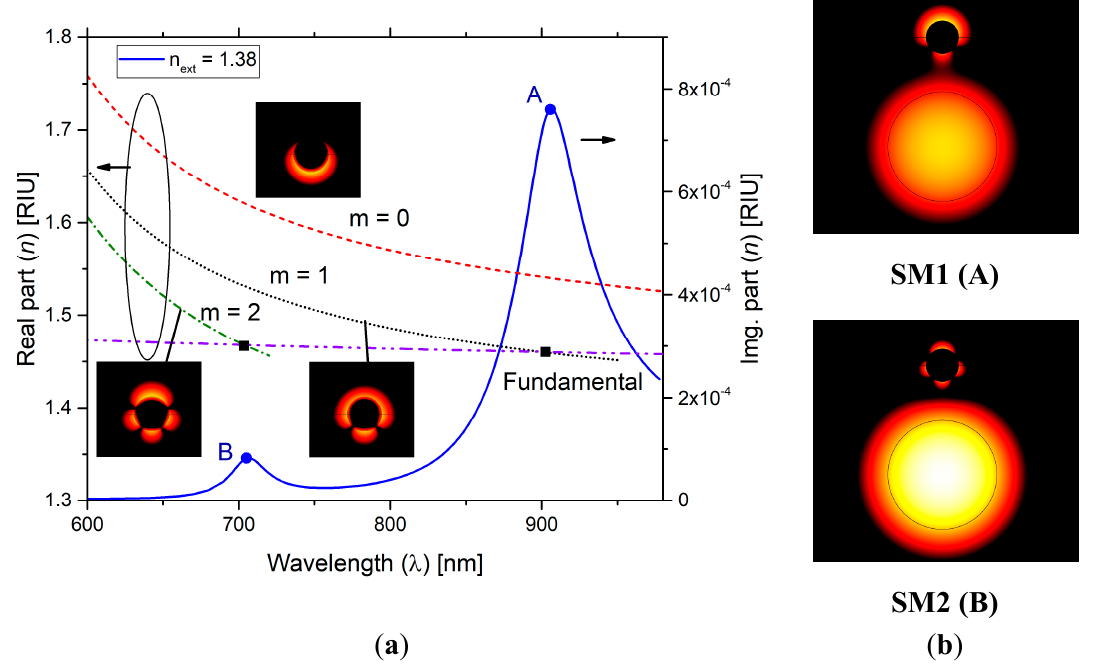
Figure 5. ( a ) Real and imaginary part of the refractive index as function of wavelength ( n ext = 1.38). ( b ) Light intensity distribution for the supermodes SM1 and SM2.